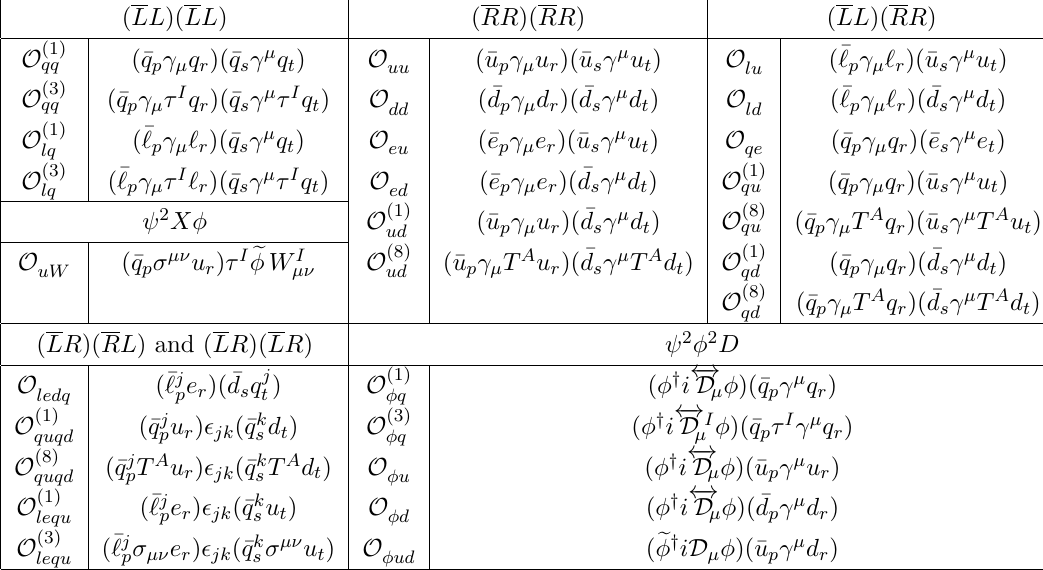
Table 4 . The SMEFT operators entering the master